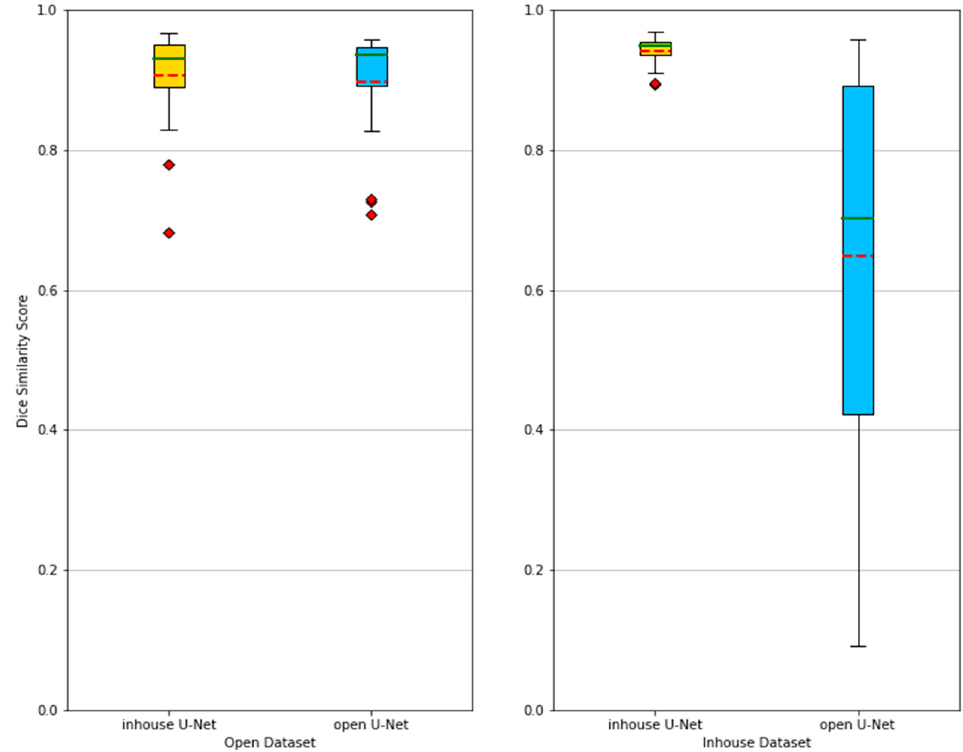
Figure 2. Boxplots showing the segmentation performances of in-house U-Net and open U-Net applied on the open and in-house test datasets. The methods are compared using the Dice similarity score (DSC). Mean (red dashed) and median (green) values are depicted. When applied to the in-house test dataset, the performance of the open U-Net generally drops and becomes more unreliable, which is depicted by a lower mean and median, as well as a larger spread between the best and worst DSC. Table 2 further gives an overview of the results.